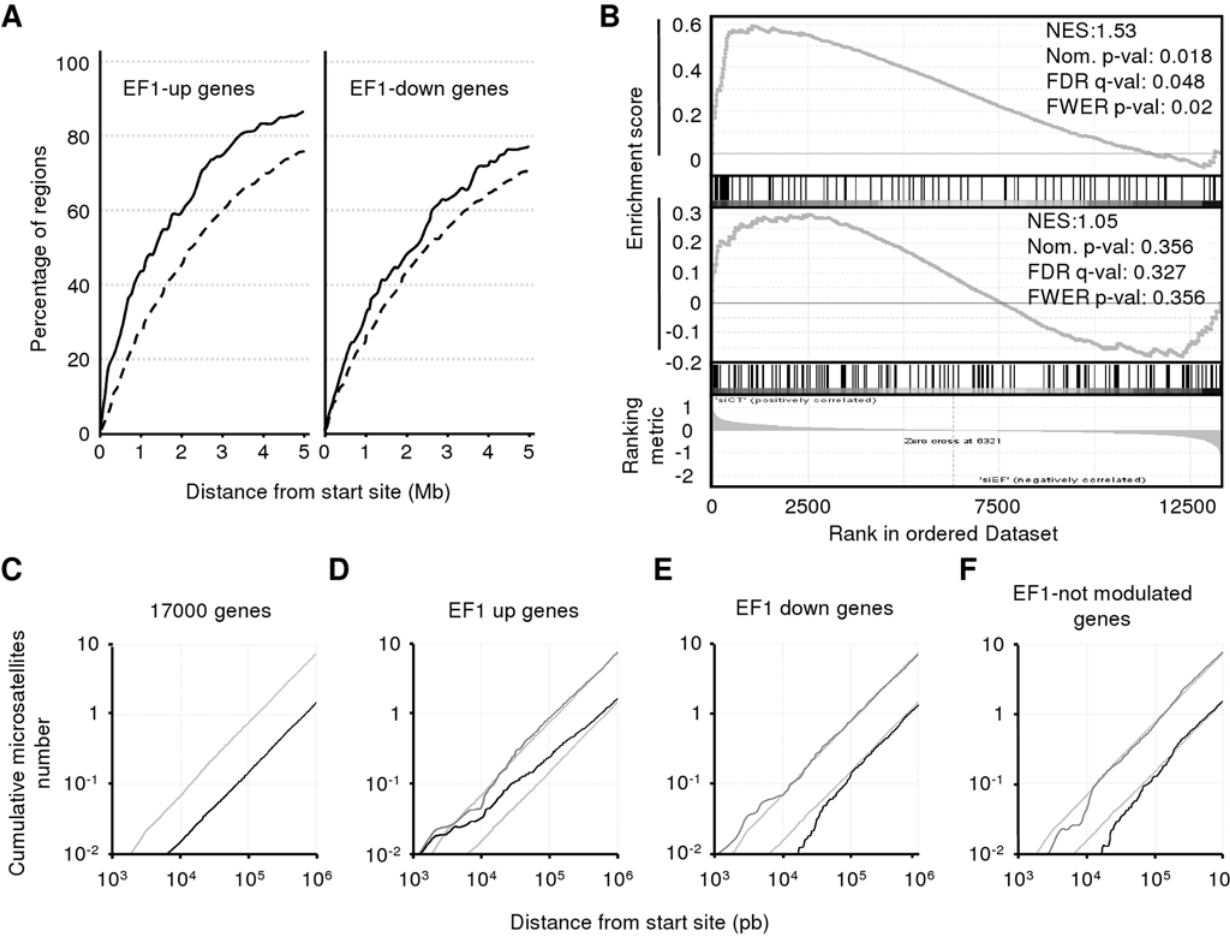
Figure 3. Long distance EWS-FLI1 binding on GGAA microsatellites results in significant gene expression activation. A. Proportion of EWS-FLI1-bound regions, as compared to the proportion of random regions, around EWS-FLI1 regulated genes. The proportion of EWS-FLI1-bound regions as a function of the distance to the transcription start sites of EWS-FLI1-up or -down regulated genes (solid lines) is shown. As a control, a similar function is indicated for 1500 randomly chosen regions (dashed line). B. Gene Set Enrichment Analysis (GSEA) of genes flanking EWS-FLI1- bound microsatellites. The 94 genes flanking the 80 microsatellites . 9R regions (upper panel) as well as the 144 genes flanking the non- microsatellites regions (lower panel) were used as gene set. The expression dataset resulted from previously described EWS-FLI1 inhibition experiments of A673 and SK-N-MC Ewing cell lines [37,40], ranked using the signal-to-noise algorithm. A strong enrichment of genes flanking EWS- FLI1 bound GGAA microsatellites among EWS-FLI1 up-regulated genes is observed (upper panel). C–F. Regions upstream of EWS-FLI1 up-regulated genes are enriched in GGAA-microsatellites. The number of microsatellites with either 3 to 9 GGAA repeats (grey line) or more than 9 repeats (black line) was calculated for each 1 Kb window from 1 Kb to 1 Mb upstream of the transcription start sites. The numbers of GGAA repeats along DNA are shown for (C) 17000 known genes (control distribution), (D) 582 EWS-FLI1-up-regulated genes, (E) 558 EWS-FLI1-down-regulated genes and (F) 561 genes that are expressed in A673 and SK-N-MC cell lines but not regulated by EWS-FLI1. The control distribution shown in C is also indicated on part D, E and F.